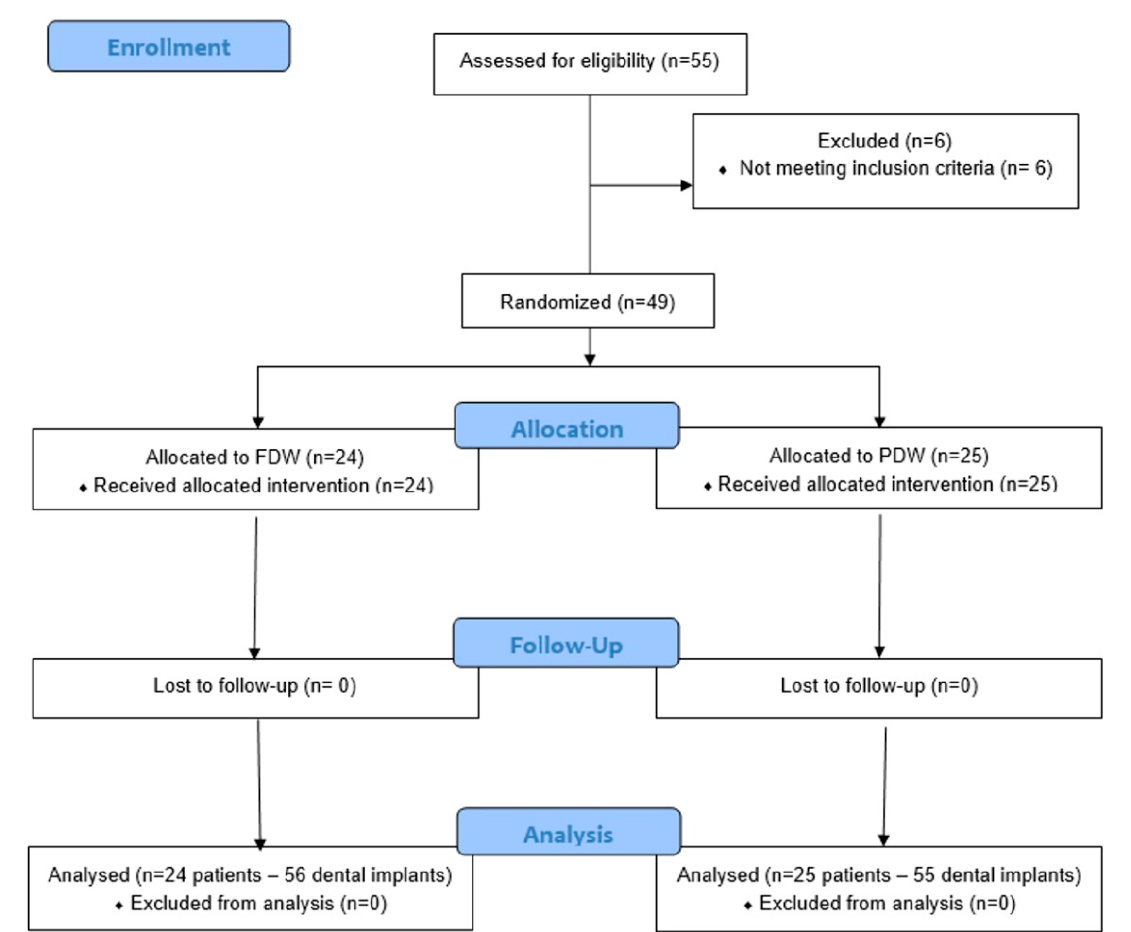
Figure 1. Consolidated Standards of Reporting Trials (CONSORT) flowchart [13]. From the 55 enrolled patients, 6 were excluded due to lack of meeting the inclusion criteria. A total of 49 patients with 66 edentulous sites were randomly assigned to one of the protocols, either fully digital workflow (FDW) or partially digital workflow (PDW) (33 sites for each protocol). A total of 56 implants were inserted in 24 patients with FDW and 55 implants were inserted in 25 patients with PDW. No loss to follow-up patients was registered at one-year evaluation period.